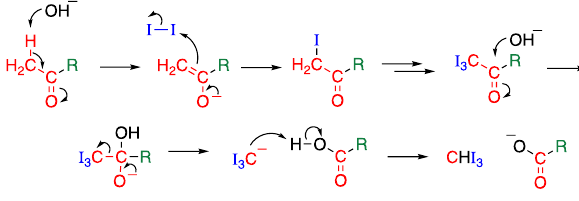
Scheme 3 Reaction mechanism for the iodoform reaction